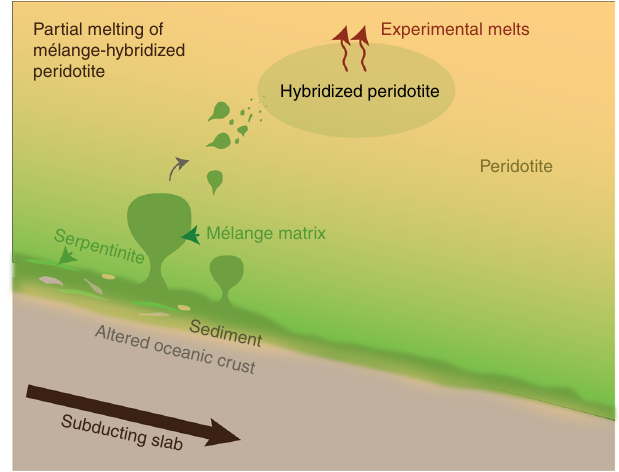
Fig. 1 Conceptual illustration of mélange-peridotite interaction in subduction zones. Experiments performed in this study simulate the partial melting of a wedge peridotite, hybridized by mélange material that ascended from the